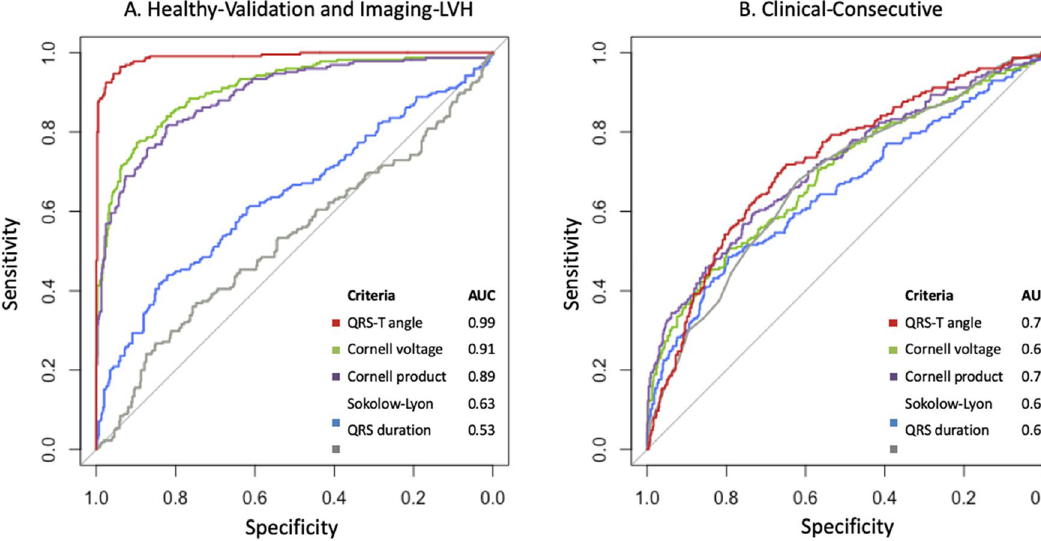
Figure 4. Area under the curve (AUC) for the evaluated criteria for detecting anatomically defined left ventricular hypertrophy. ( A ) AUC for the criteria in the combined Healthy-Validation and Imaging-LVH cohorts. ( B ) AUC for the criteria in the Clinical-Consecutive cohort.